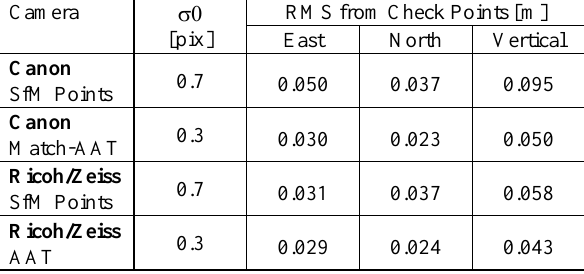
Table 1: 3D check point accuracy from AT.